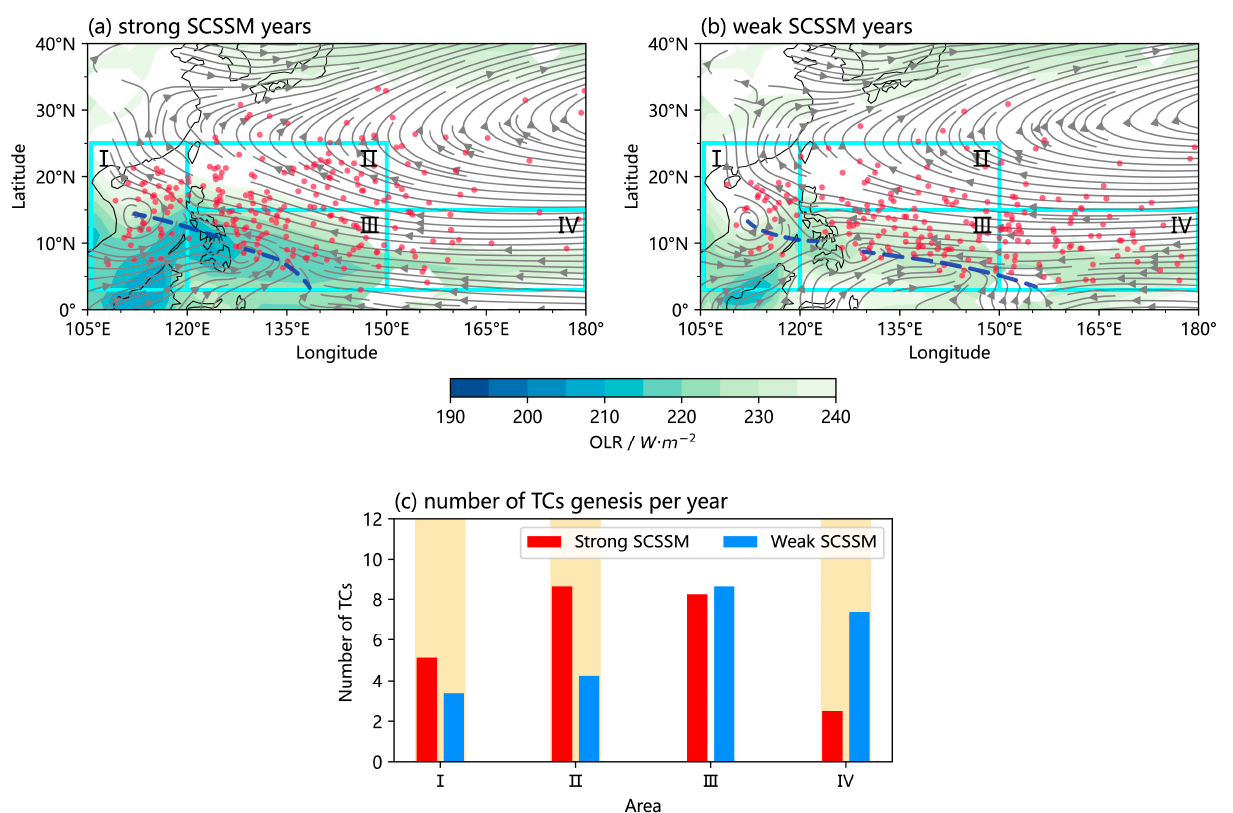
Figure 6. An 850 hPa horizontal wind field (streamline) and OLR (shade) during TC season (May to December) in ( a ) SCSSM strong years and ( b ) SCSSM weak years, respectively, regressed against the annual I SM . The regression elements have statistical significance at the 90% confidence level. The MT is denoted by a purple, thick-dashed line. The solid red dots represent the locations of TC genesis. The blue boxes represent four sub-regions: Area I (i.e., SCS, 3 ◦ –25 ◦ N, 105 ◦ –120 ◦ E), Area II (15 ◦ –25 ◦ N, 120 ◦ –150 ◦ E), Area III (3 ◦ –15 ◦ N, 120 ◦ –150 ◦ E), and Area IV (3 ◦ –15 ◦ N, 150 ◦ –180 ◦ E). The bar charts ( c ) show the number of TCs genesis per year in each area during TC season, in which strong SCSSM years are in red and weak SCSSM years are in blue, with yellow shading indicating that the differences are significant at 90% confidence level.